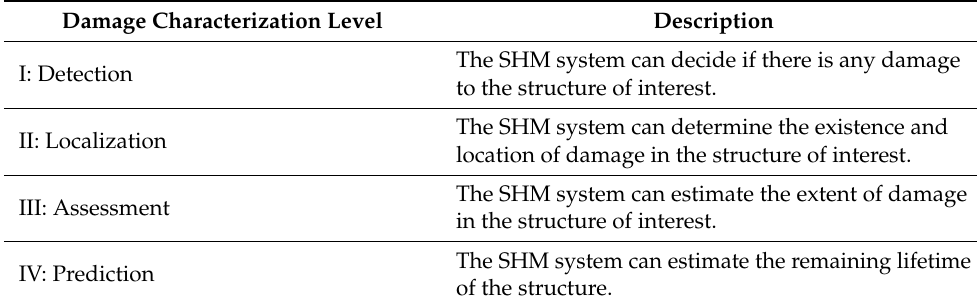
Table 1. Damage characterization